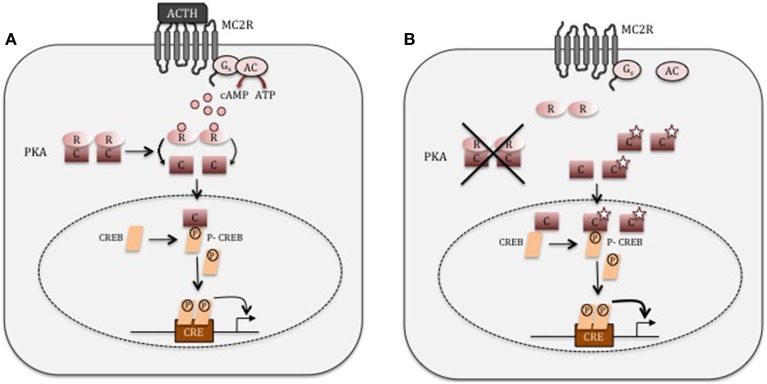
cAMP signaling. (A) In normal adrenocortical cells, ACTH binds to its G-coupled receptor, MC2R. This leads to the activation of adenylate cyclase (AC), which convert ATP into cAMP. cAMP then binds the regulatory (R) subunit of PKA, inducing the release of the catalytic subunit (C). The catalytic subunit phosphorylates its downstream target such as CREB, which in turn induces the expression of genes involved in cortisol synthesis. (B) In adrenocortical adenoma cells producing cortisol autonomously with PRKACA mutations (star), the catalytic (C) subunit of PKA is unable to interact with the regulatory subunit (R). The unregulated PRKACA may now mediate its serine-threonine kinase activity without any restrains.